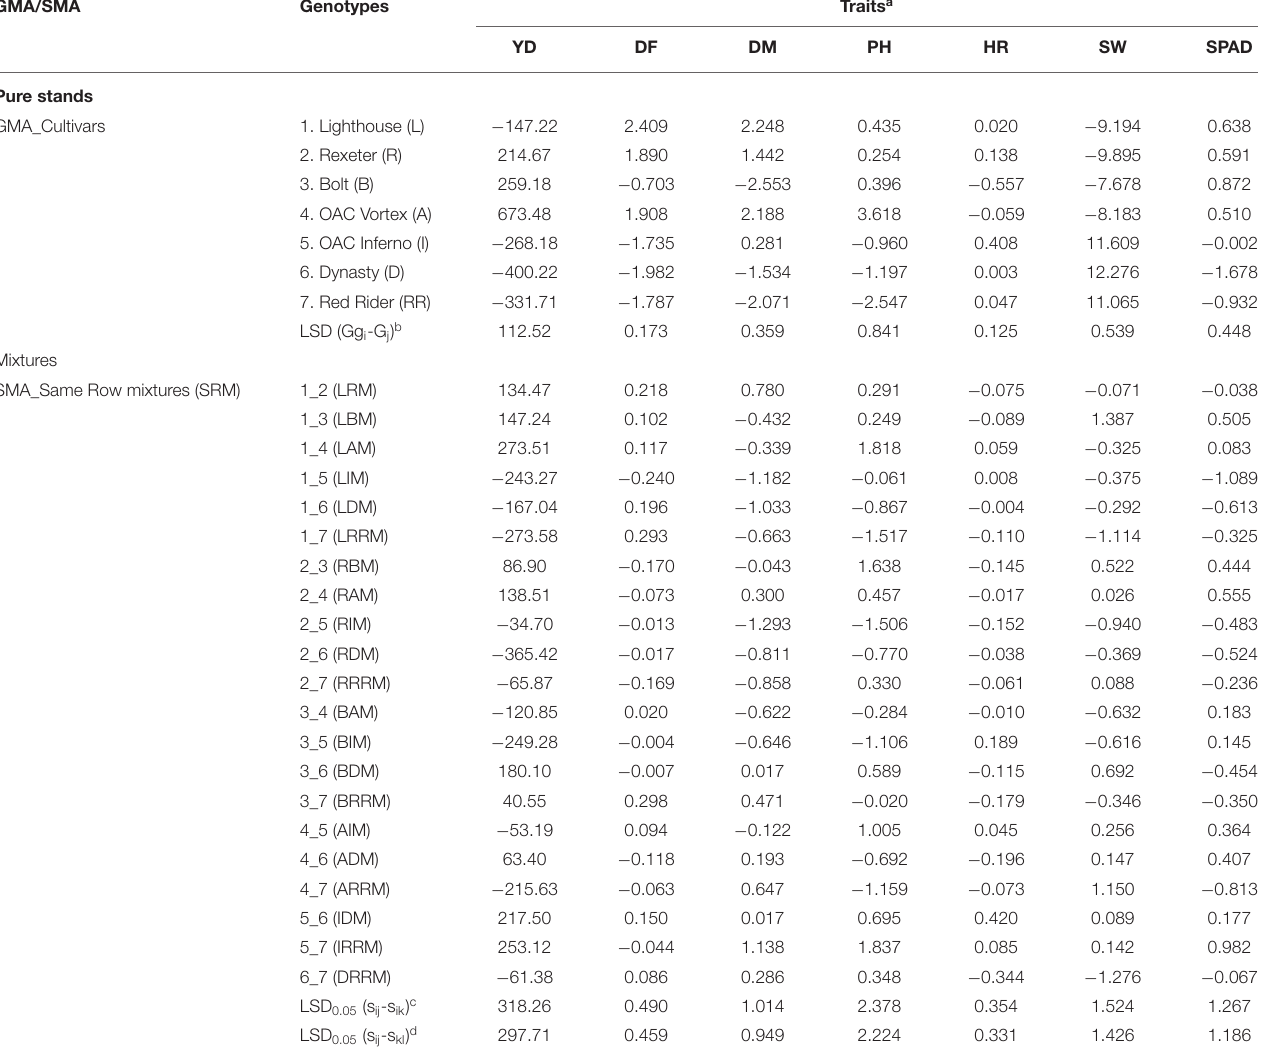
TABLE 5 | Estimated general mixing ability (GMA) for traits analyzed in seven bean genotypes and specific mixing ability (SMA) of their same row binary mixtures (SRM) averaged over three Ontario environments/locations in 2018.